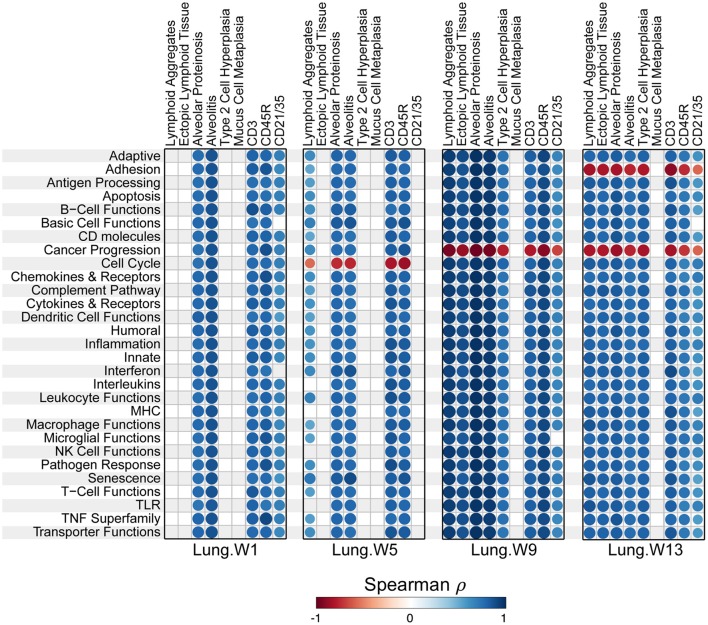
Correlation analyses of immune-associated pathways and phenotypic endpoints assessed in lung tissues of mice collected 1, 5, 9, or 13 weeks post instillation with cSiO2. Spearman ρ values were calculated using pathway Z scores and phenotype data (histopathology scores (lymphoid aggregates, ectopic lymphoid tissue, alveolar proteinosis, alveolitis, type 2 cell hyperplasia, and mucus cell metaplasia) or percent positive staining tissue (CD3, CD45R, and CD21/35). Significant correlation values (p < 0.05) are represented as circles colored by the correlation value (blue, positive; red, negative); non-significant correlations are indicated by blank cells.